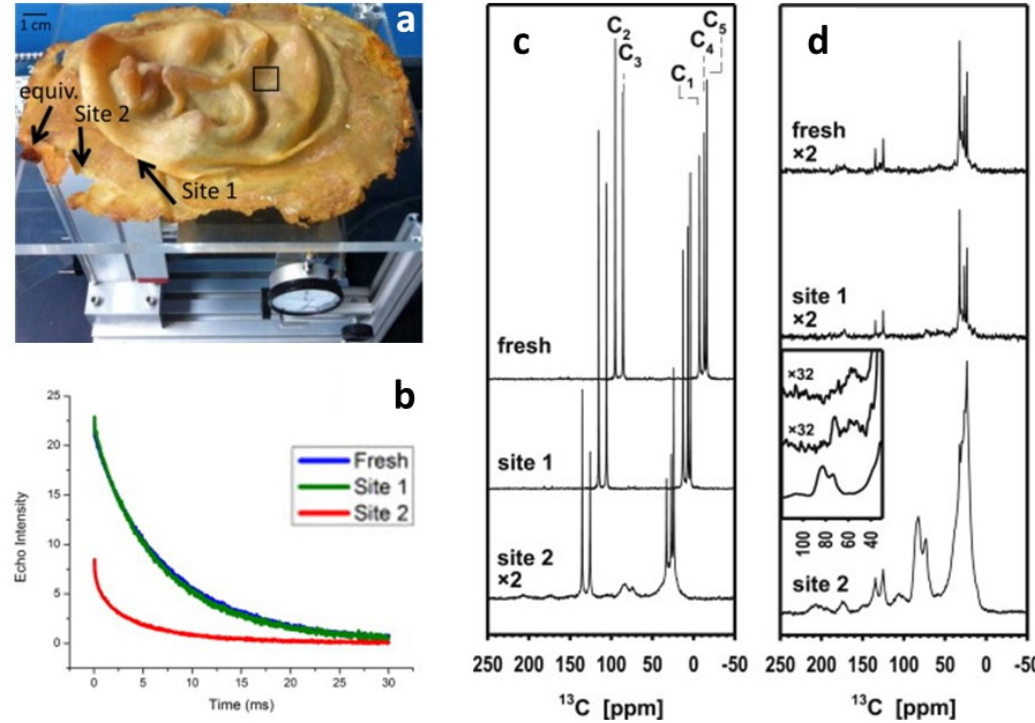
Figure 8. ( a ) Five-year-old natural latex mask by L. Isolani on unilateral NMR instrument. Arrows mark the less degraded site 1, site 2 and a site with degradation similar to site 2. ( b ) Relaxation decays acquired with unilateral NMR (blue: fresh reference sample; green: site 1; red: site 2). ( c ) 13 C DEPTH spectra of a fresh preparation of natural rubber and samples of the artwork taken from site 1 and site 2. The upper two spectra are shifted for better visibility. ( d ) 13 C CP spectra of the same samples. The insert shows excerpts of the CP spectra with more line broadening (100 instead of 20 Hz; the order is top: fresh, center: site 1, bottom: site 2). Image reprinted with permission from [60].